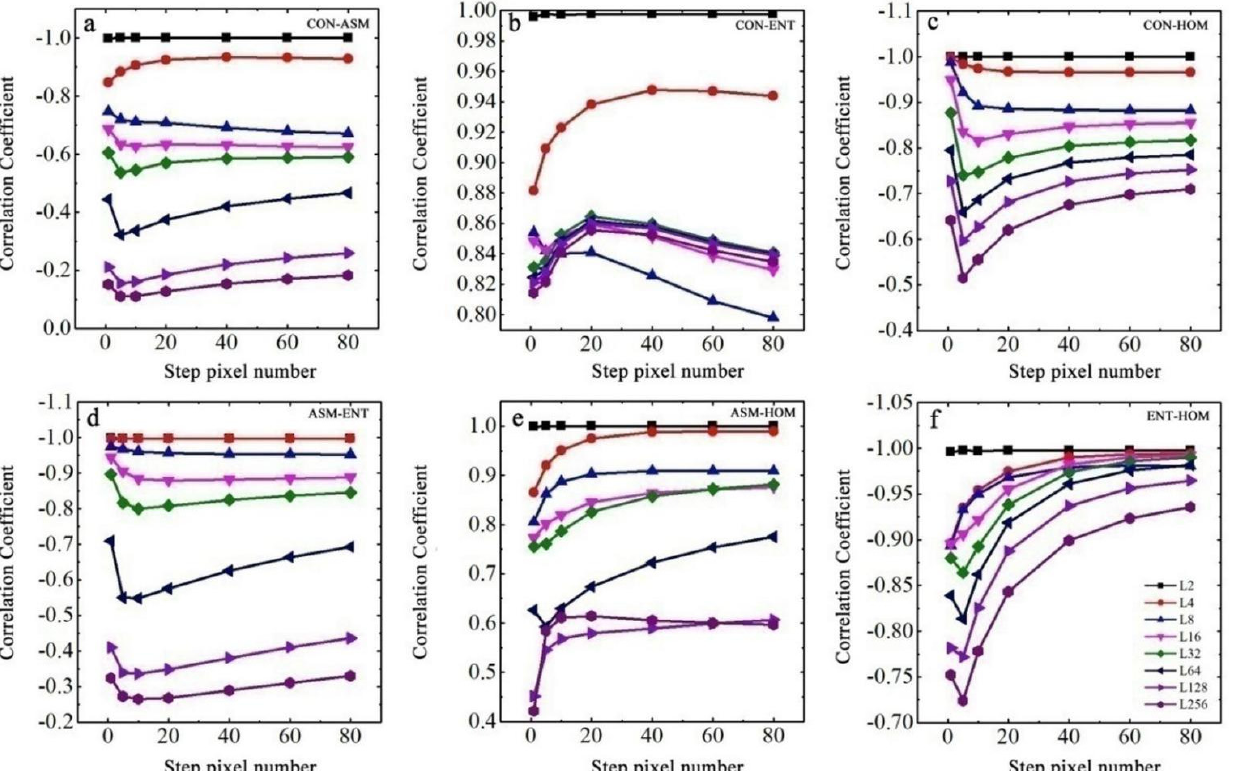
Figure 8. Cross − correlation coefficients of four GLCM texture features of the cracked soil samples. ( a ) between CON and ASM; ( b ) between CON and ENT; ( c ) between CON and HOM; ( d ) between ASM and ENT; ( e ) between ASM and HOM; ( f ) between ENT and HOM.